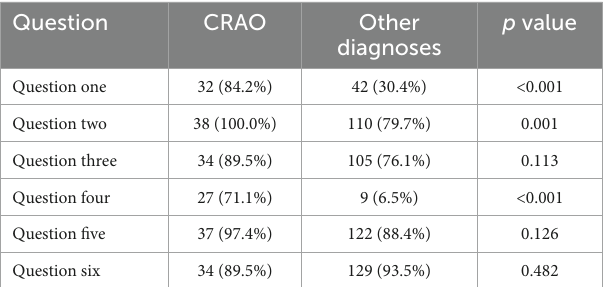
TABLE 2 Absolute and relative frequencies of positive answers for CRAO patients and patients with other diagnoses.